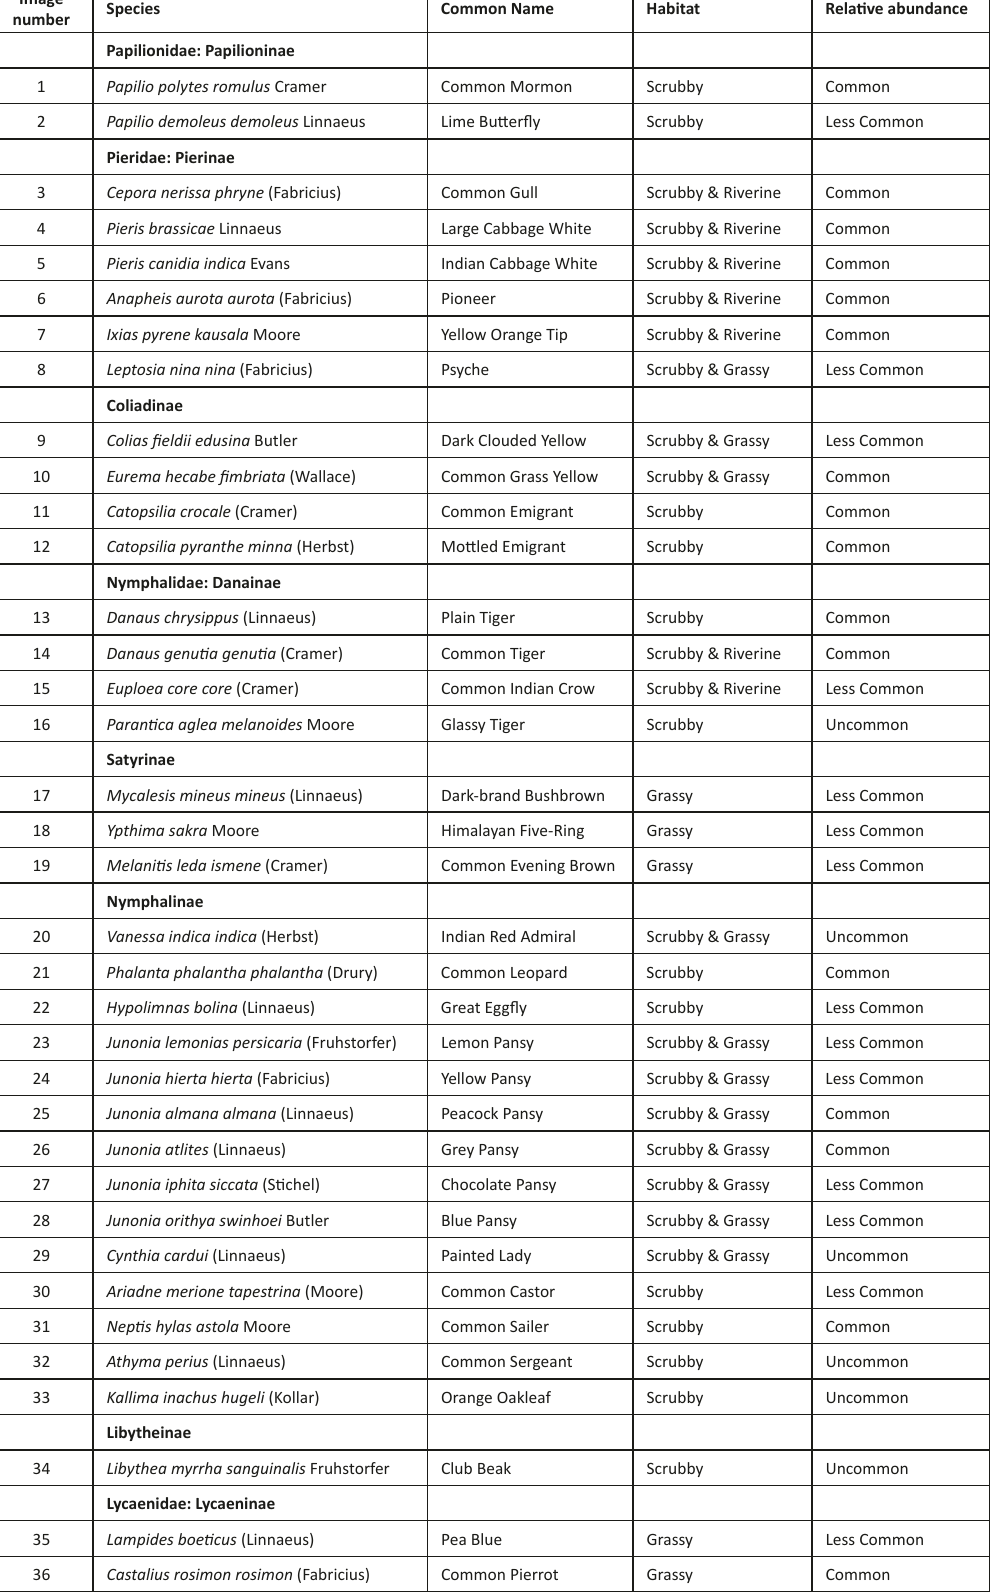
Table 1 . Systematic list of butterfly species recorded from Kathlaur-Kaushlian Wildlife Sanctuary, Pathankot District, Punjab, India